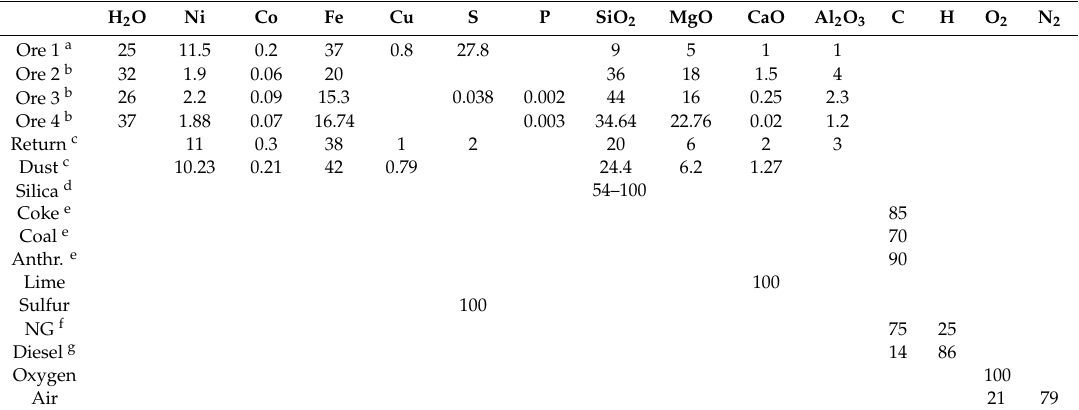
Table 5. Chemistry of raw materials and fuels (unit: H 2 O-mass %; CH 4 , O 2 , N 2 -vol%; rest-dry